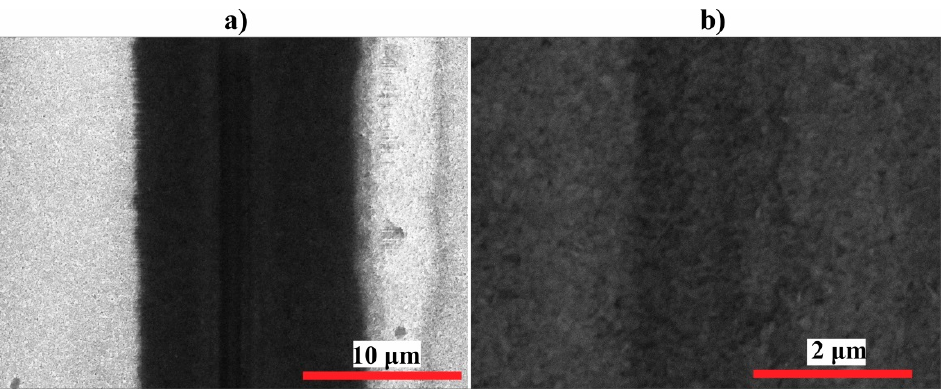
Figure 9. SEM images of ( a ) the blackened line segment and ( b ) the bottom of the blackened line segment on the HP-HT ND film.